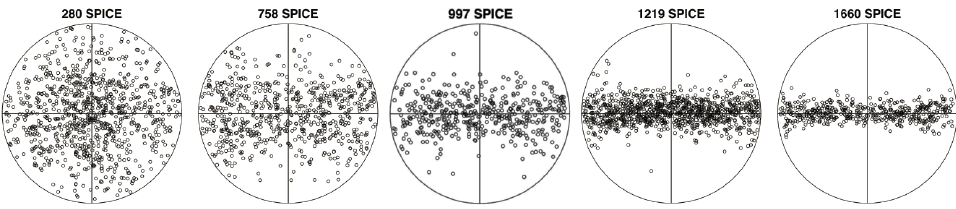
Figure 2. Depth development of c -axis distributions (Lambert azimuthal equal-area projections) measured in SPICEcore. Depths (in meters) are indicated above each diagram. They show a clean girdle fabric below ∼ 1000m. Adapted from Voigt (2017).